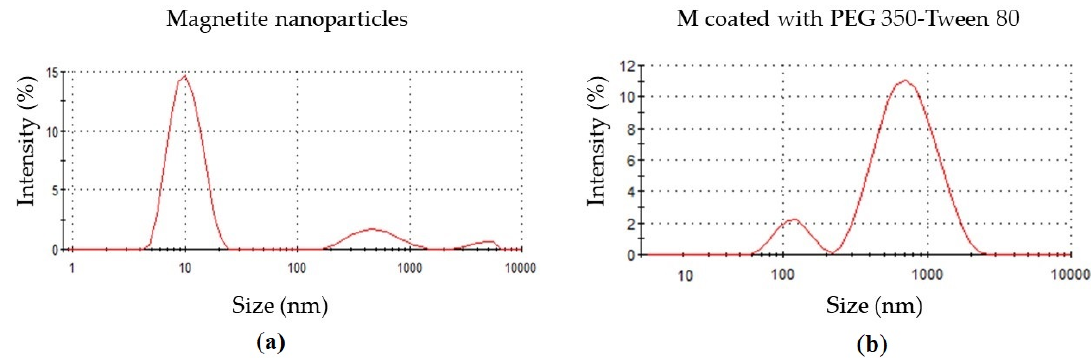
Figure 5. Dynamic light scattering (DLS) sizes results. ( a ) Bare magnetite nanoparticles size distribution. With an average size of 10.51 nm 83.8% of the nanoparticles do not generate agglomerates. The 13.6% of the nanoparticles generates agglomerates of 527.8 nm and the other 2.6% generates agglomerates of 4367 nm. ( b ) Magnetite nanoparticles coated with PEG 3350-Tween 80 size distribution. With an average size of 119.2 nm 10.3% of the nanoparticles do not generate agglomerates. The 89.7% of the nanoparticles generates agglomerates of 785.6 nm.